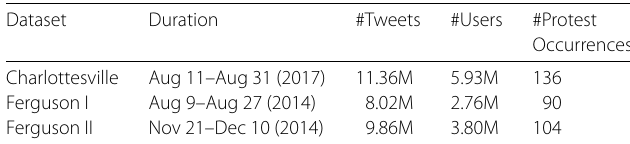
Table 1 Basic statistics of the